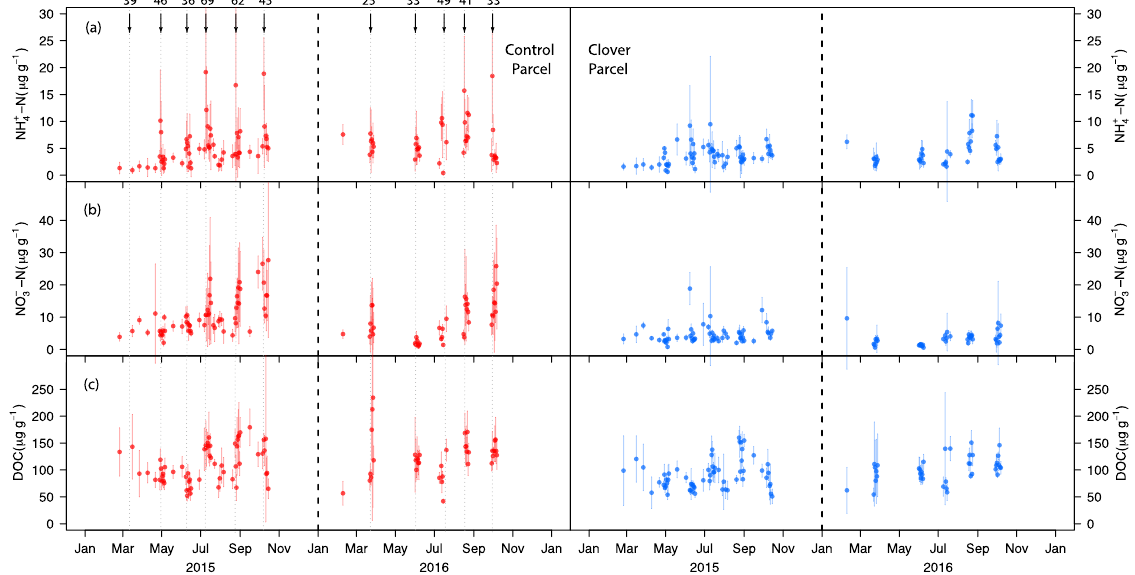
Figure 4. (a) Ammonium-N concentration, (b) nitrate-N concentration, and (c) dissolved organic carbon concentration per unit of dry soil at the control (left, red) and clover parcel (right, blue) during 2015 and 2016. Black arrows indicate slurry applications, which only took place in the control parcel. The numbers above the arrows indicate the amount of N (kgha − 1 ) added to the parcel.